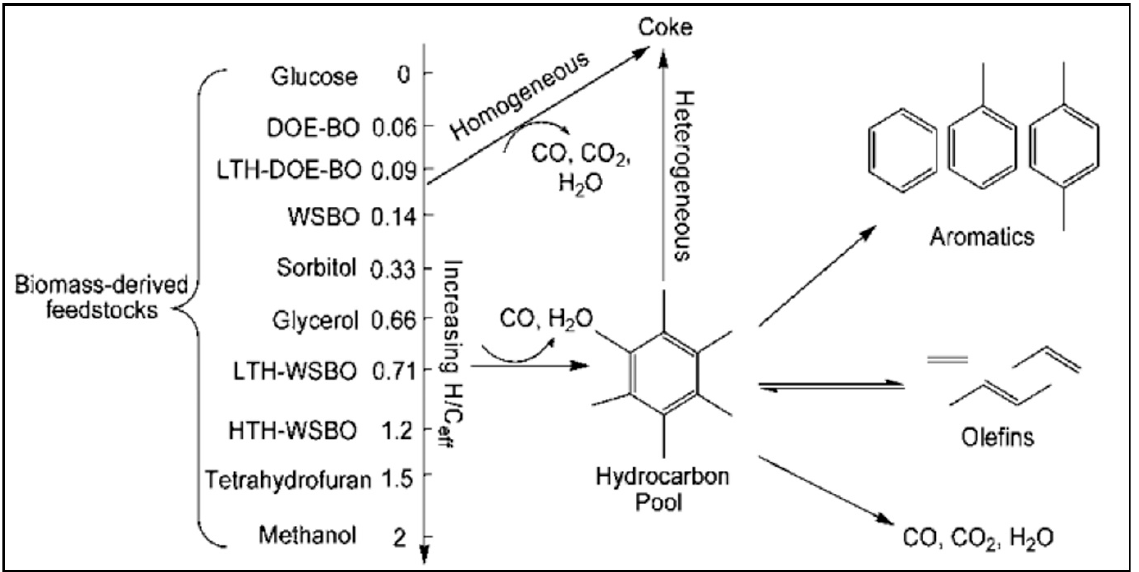
Figure 6. Reaction schematic of biomass-derived feedstocks with ZSM-5 catalyst (Zhang et al., 2011, The Royal Society of Chemistry) [116].